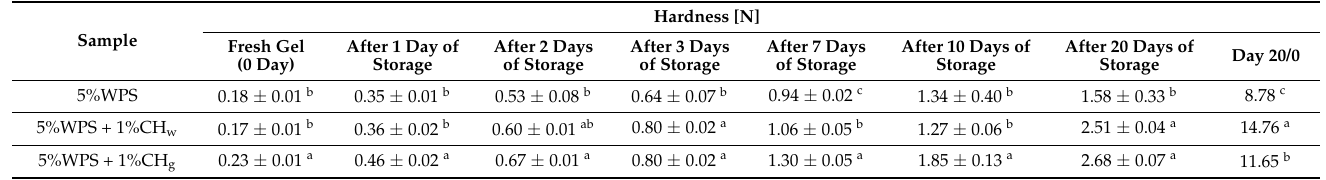
Table 6. Gel hardness (N) of 5% WPS and its mixtures with 1% CH (whole and ground) measured as fresh gels and gels stored for 20 days at 4 ◦